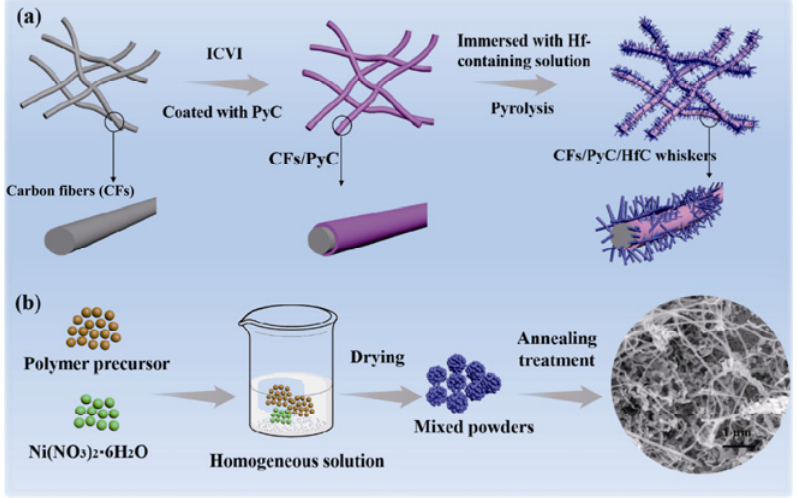
Fig. 1 Schematic diagram. (a) Preparation process of HfC whiskers; (b) fabrication process of CNT–HfC/HfO 2